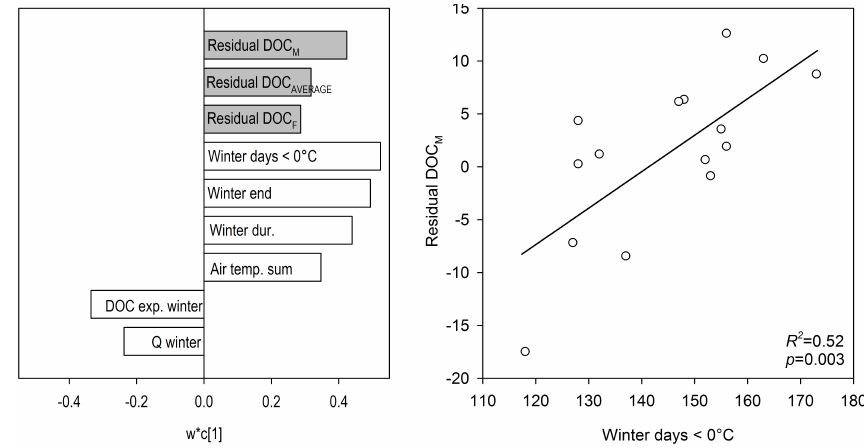
Fig. 6. Left panel: PLS weight plot ( R 2 X = 0.54, R 2 Y = 0.38, Q 2 = 0.23), showing that high soil water DOC concentrations, inferred from stream DOC, (indicated by the Residual DOC concentrations) correlate positively to long cold winters and negatively to a high previous DOC export during winter. This means higher soil water DOC concentrations after long winters with low export. The Y variables are marked in grey and the six significant (90% significance level) X variables in white. Right panel: Linear regression between Residual DOC M and Winter days < 0 ◦ C (the variables with the highest weights), illustrating the relationship between long severe winters and spring flood DOC